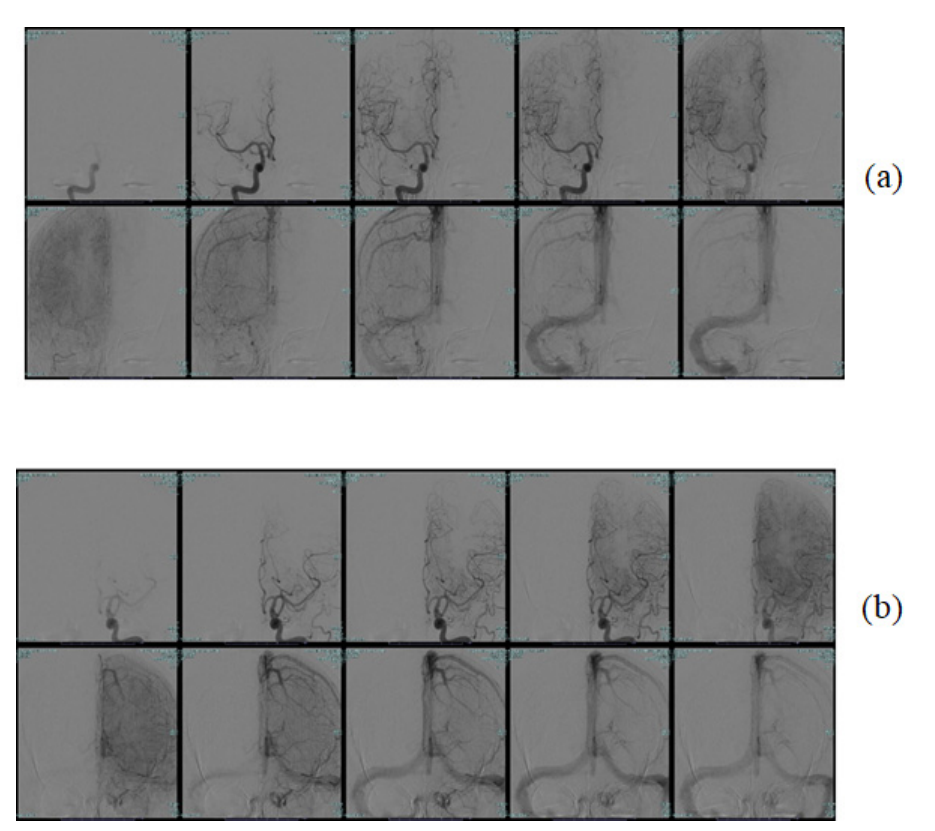
Figure 2. Sample of DSA scans: ( a ) selective right internal carotid artery, and ( b ) selective left internal carotid artery.